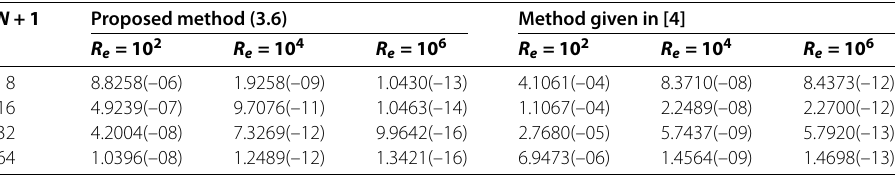
Table 13 Example 4: Case 4.4: Maximum absolute errors α = 1, β =